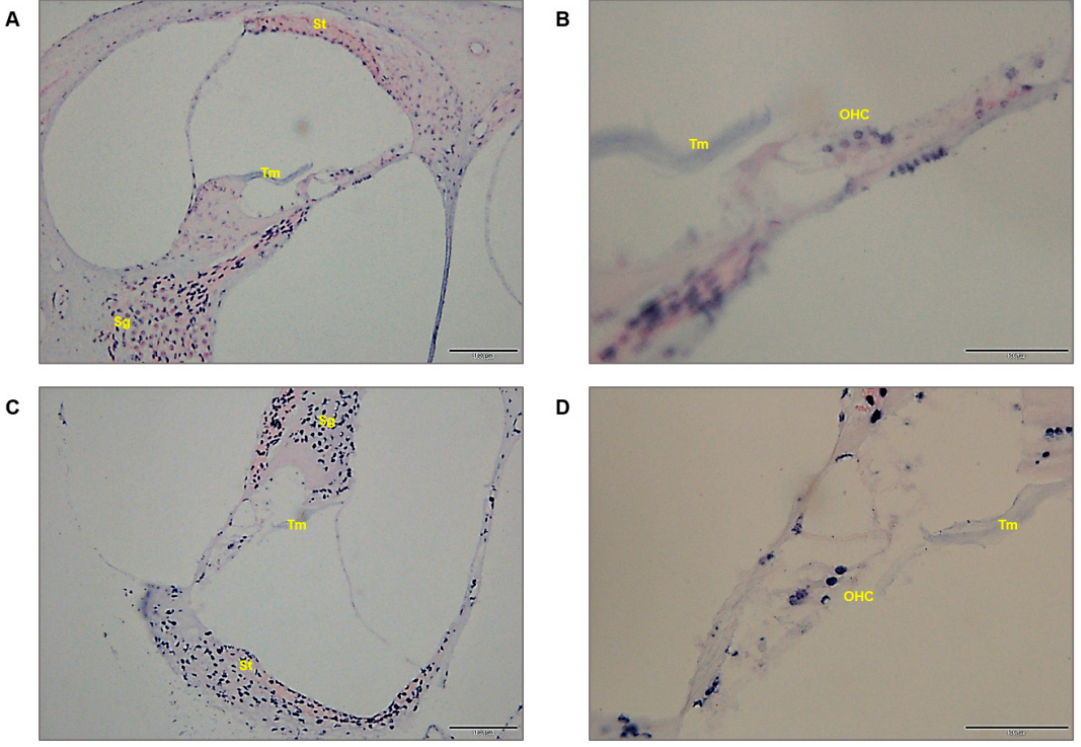
Figure 4. miR-205-specific in situ hybridization analysis. The expression of miR-205 in normal ( A , B ) and ototoxicity groups ( C , D ). Normal and ototoxicity mouse groups were positively stained in the spiral ganglion and outer hair cells. However, miR-205-positive staining was observed, especially in the stria vascularis of the ototoxicity-induced mouse group. Stria vascularis, St; spiral ganglion, Sg; outer hair cell, OHC; tectorial membrane, Tm. The magnification of ( A , C ) is 400×, and the scale bar is 100 μ M. ( B , D ) represent 600× magnification, and the scale bar is 50 μ M.